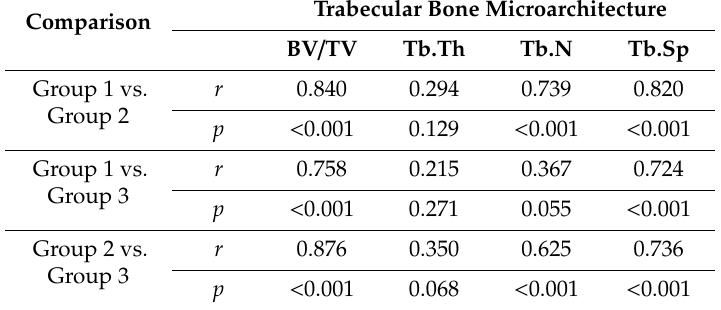
Table 3. Correlation coe ffi cients for trabecular bone microarchitectural measurements between the three